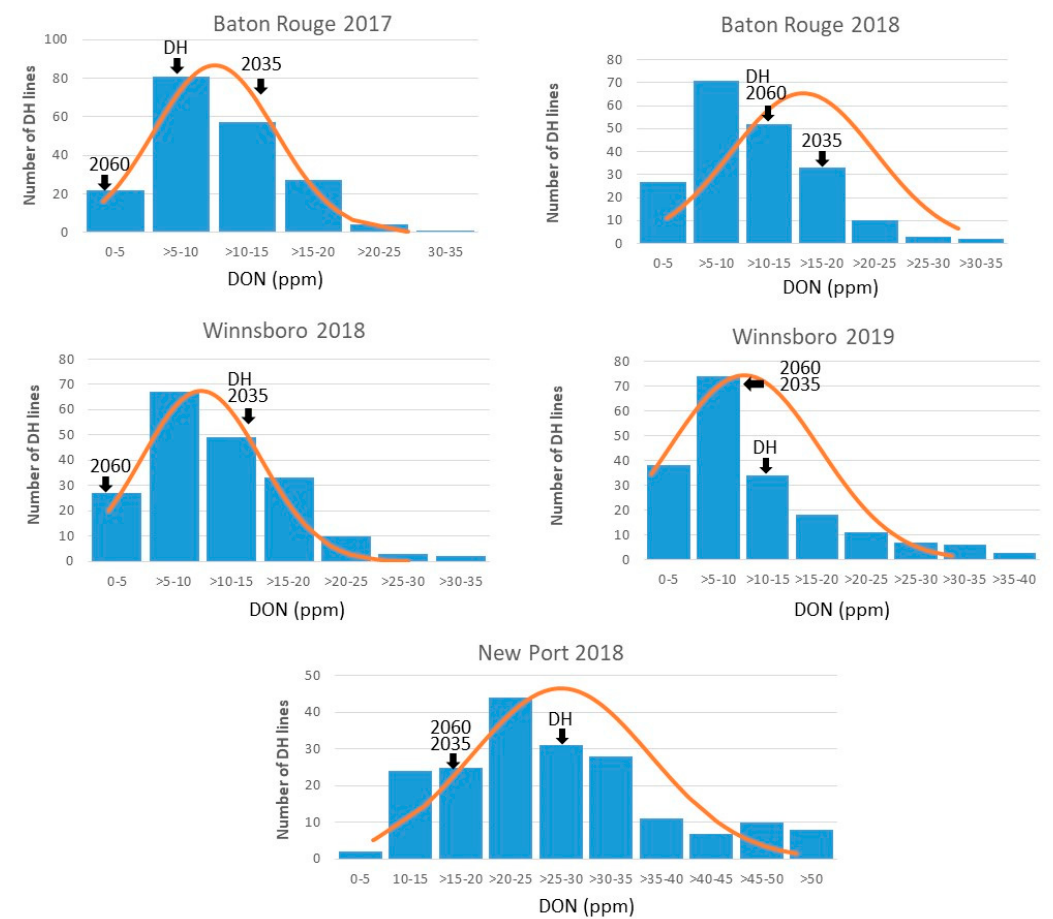
Figure 1. Phenotypic distribution of deoxynivalenol (DON) concentration for field trials in Baton Rouge, LA during 2017 and 2018; Winnsboro, LA during 2018 and 2019; Newport, AR during 2018. Parental and population means are marked by arrows. 2060, 2035, and DH represent mean values for AGS 2060, AGS 2035, and DH population, respectively. The normality of the data was tested using the Shapiro–Wilk test in R. Distribution was considered near-normal when p -values were less than but close to 0.05.